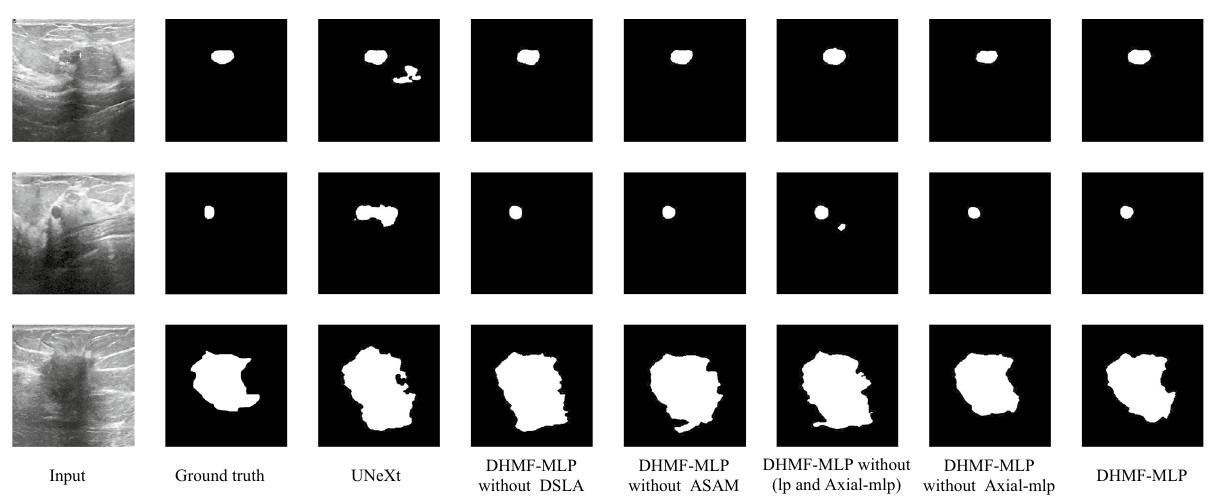
Axial-mlpDHMF-MLP DHMF-MLP DHMF-MLPDHMF-MLP DSLAInput without without ASAM without Figure 8. Ablation segmentation results of HMSF block on the BUSI dataset. From left to right: input, ground truth, UNeXt 22 , DHMF-MLP without DSLA, DHMF-MLP without ASAM, DHMF-MLP without (lp and